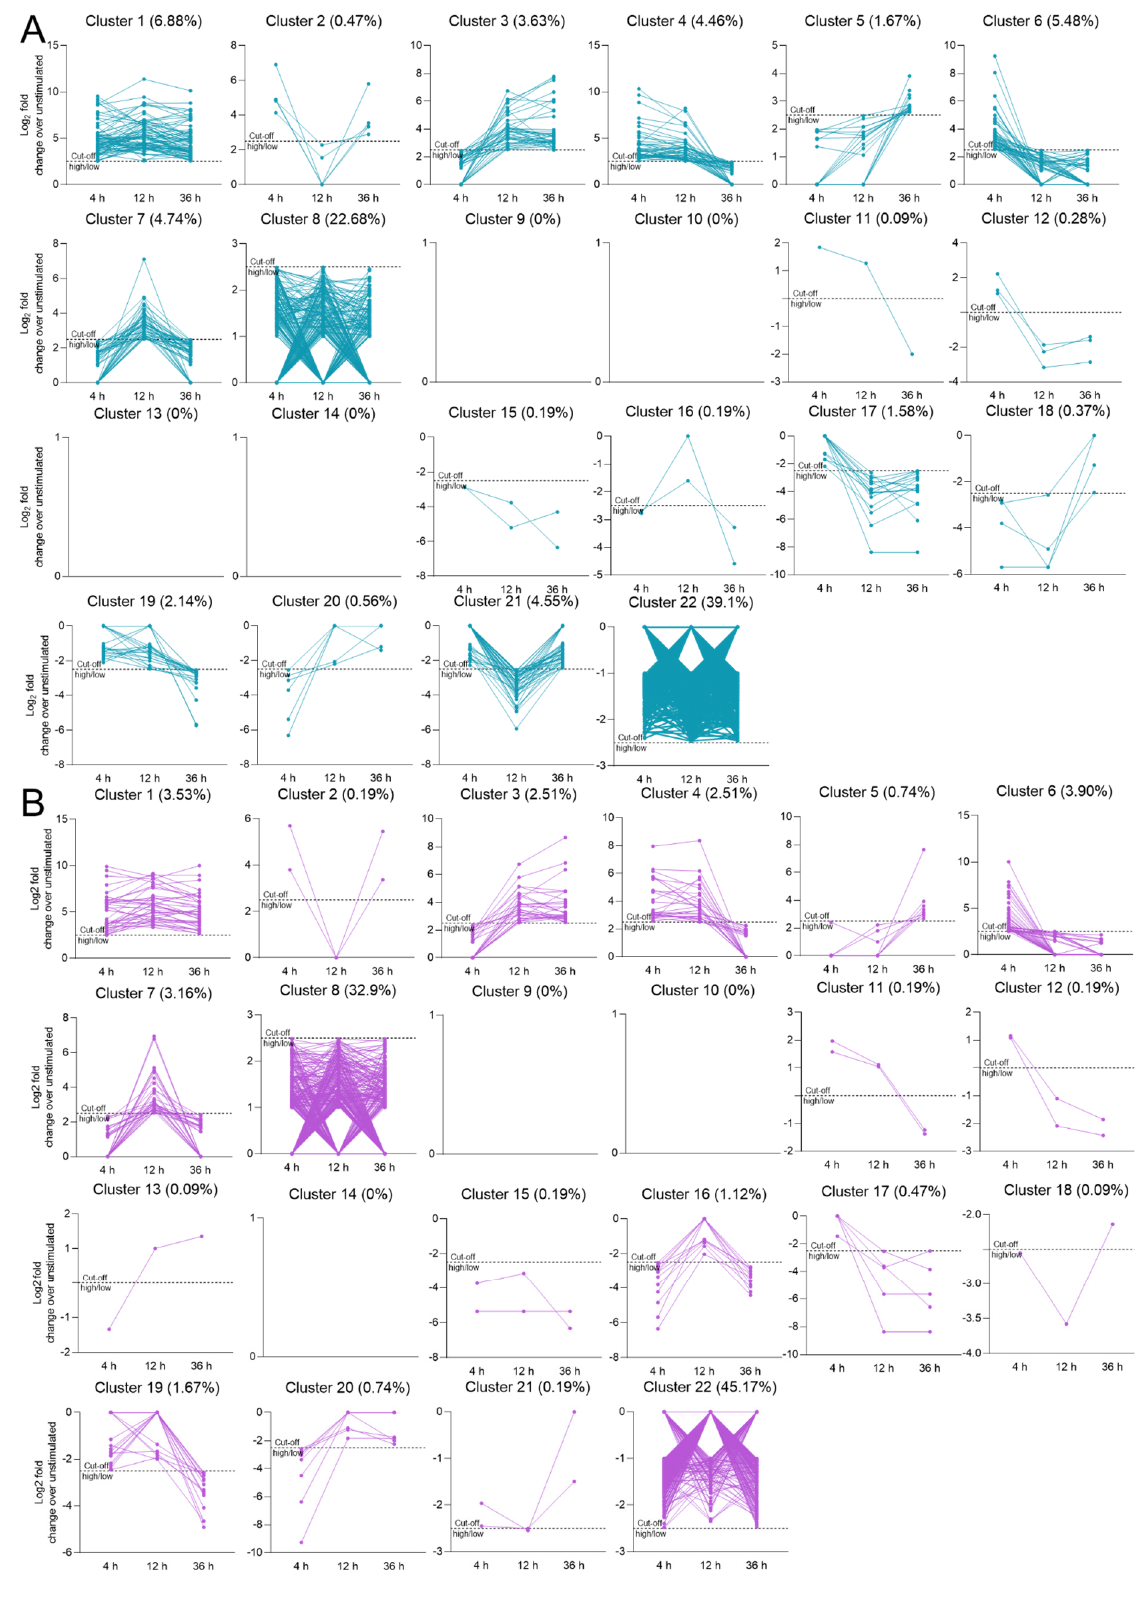
Figure 4. Cluster analysis of the expression profiles of the differentially expressed genes (DEGs) following ( A ) TNF α stimulation and ( B ) IL-1 β stimulation of human cortical spheroids (hCSs) for 4 h, 12 h and 36 h. The 1076 DEGs overlapping between the TNF α - and IL-1 β -modulated hCS DEG lists of the three stimulation time points were analysed.